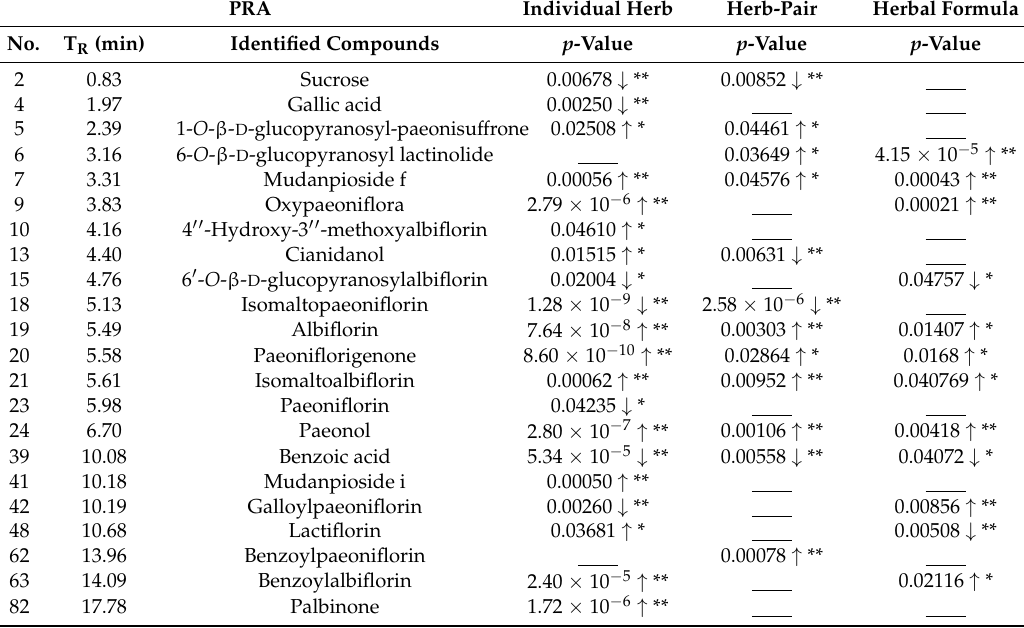
Table 3. Results of t -test of 22 peaks from PRA showing significant difference in individual herb, herb-pair, and complicated Chinese herbal formula before and after processing ( n = 6). PRA Individual Herb Herb-Pair Herbal